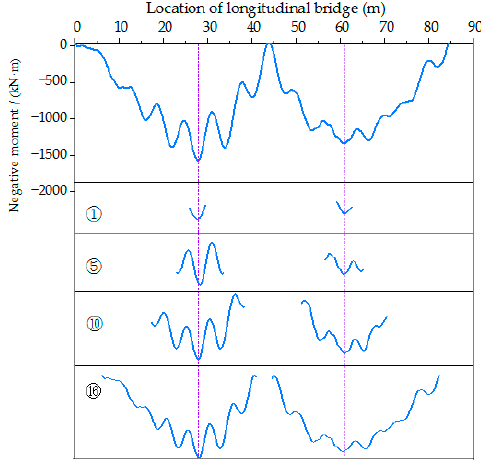
Figure 13. Intercepted segments of time-history curves. Table 3. Parameters of the segments.